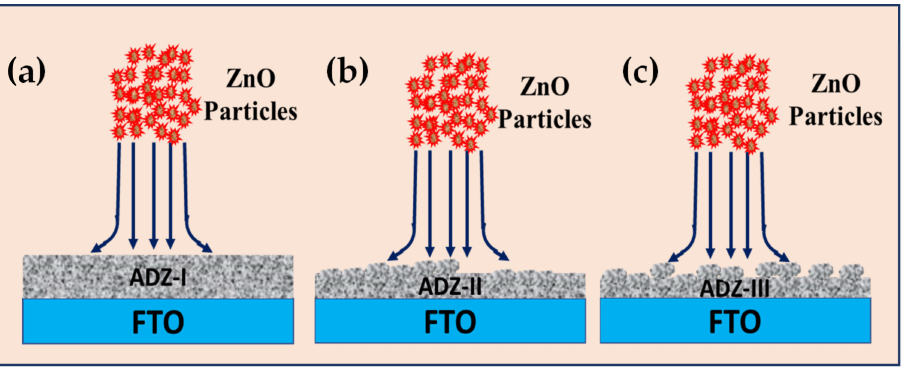
Figure 7. Schematic representing the formation of ZnO films using the AD method under different deposition cycles ( a ) AZ-I, ( b ) AZ-II, and ( c )